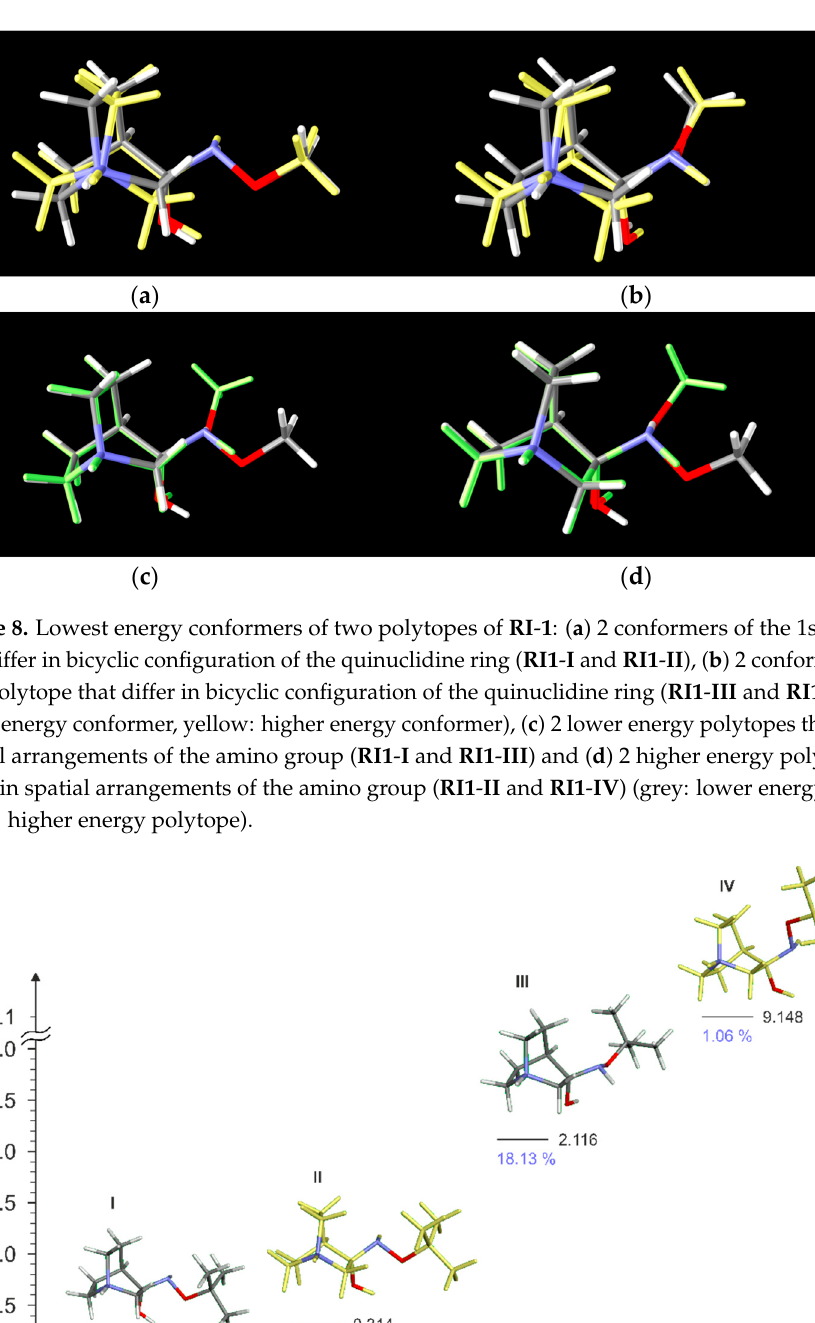
Figure 7. Four lowest energy conformers of 1·HCl and their relative standards Gibbs energies of formation Δ f G °calculated at the B3LYP-D3/6-311++G(d,p) level of the theory. (Relative fractions ac- cording to Boltzmann distribution at 298.15 K are given in blue.)